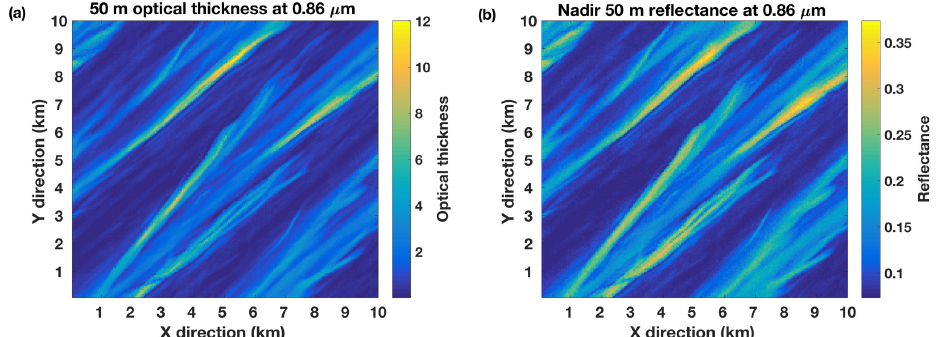
Figure 2. (a) Optical thickness field at 0 . 86µm and (b) solar reflectance field at 0 . 86µm at a spatial resolution of 50m, with nadir view and overhead Sun.